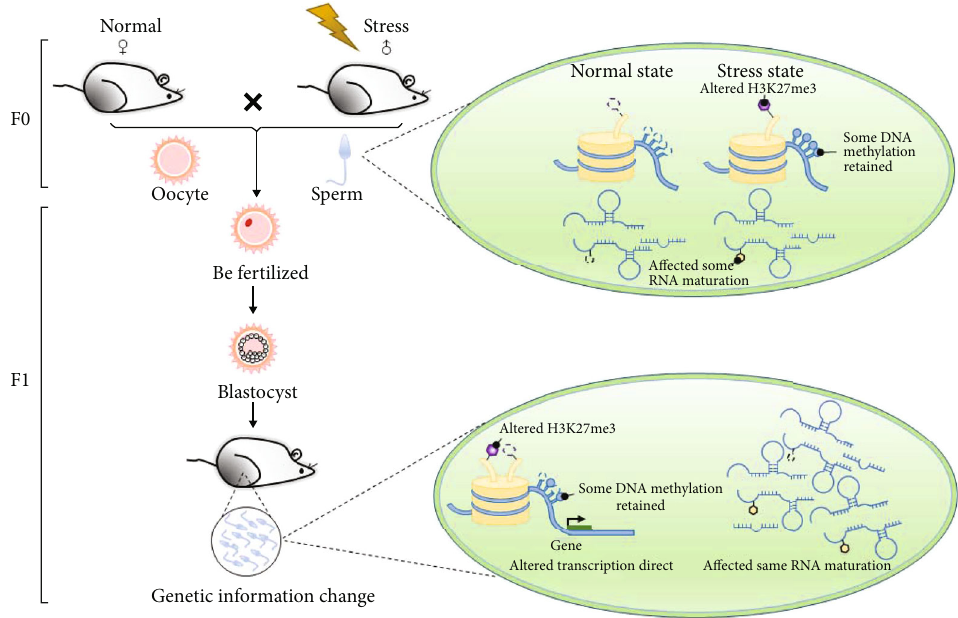
Figure 1: The genetic information of the sperm changes after stress. Under stress, histone H3K27me3 modi fi cation, DNA methylation, and RNA maturation were a ff ected in the F0 sperm cells. Some of these modi fi cations can “ continue ” in the zygote and “ inherit ” this “ marker ” to the male